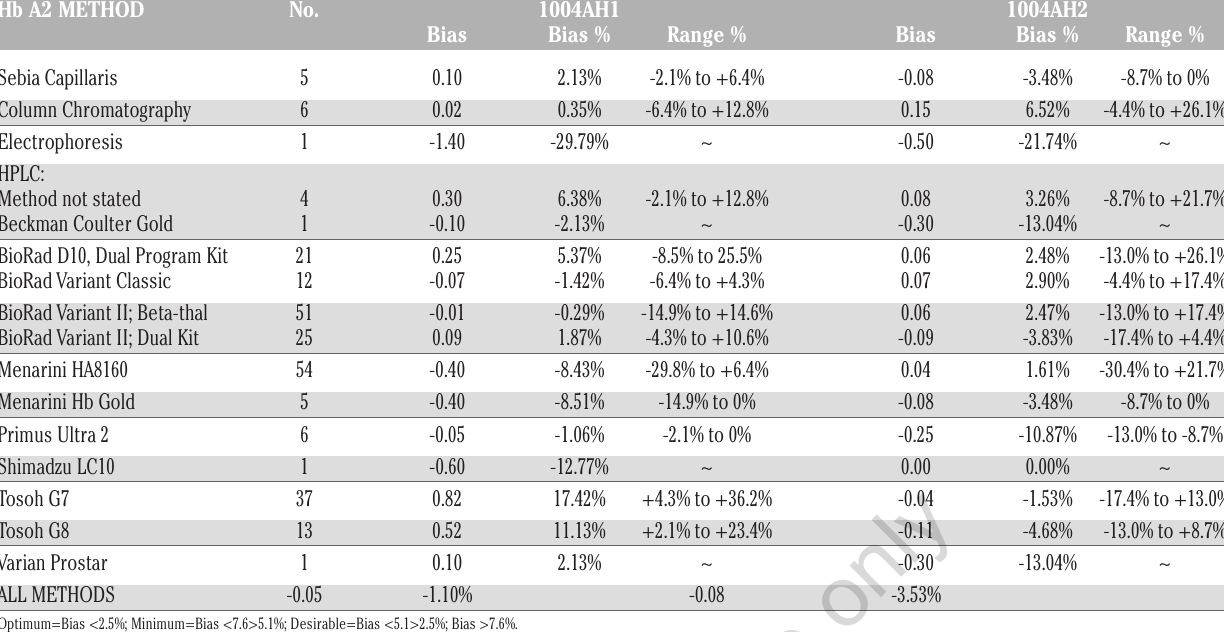
Table 3. Method bias seen in the Hb A2 EQA survey, by method principle / analyser